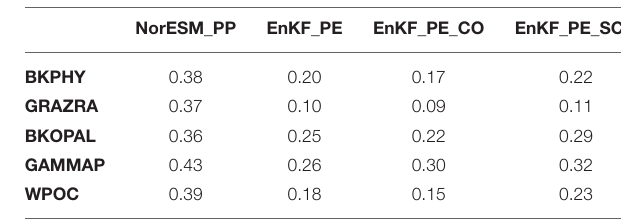
TABLE 2 | Spatial average of the point-wise ensemble RMSE of the parameter values obtained at the end of the estimation period (December